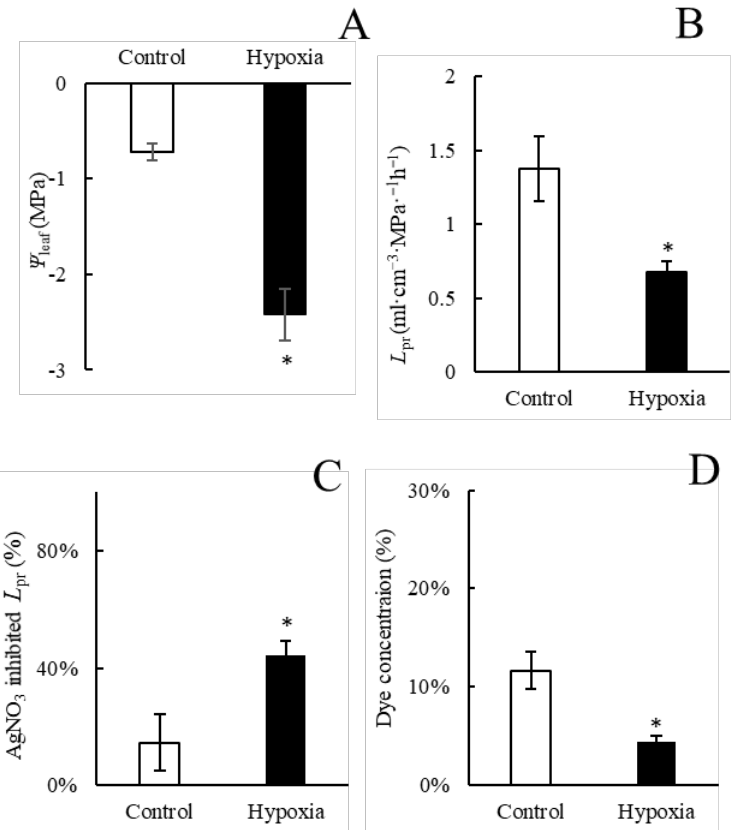
Figure 3. Leaf water potential ( Ψ leaf , A ),root hydraulic conductivity ( L pr , B ), L pr in plants treated with AgNO 3 (% control) ( C ), and percentage of the apoplastic light green SF yellowish dye concentra- tion of the concentration applied to roots ( D ) in aerated plants and in plants subjected to hypoxia for three days. Means ± SE are shown ( n = 6 – 8). Asterisks indicate a difference between aerated and hypoxia ( p ≤ 0.05 denoted by *; t -test).